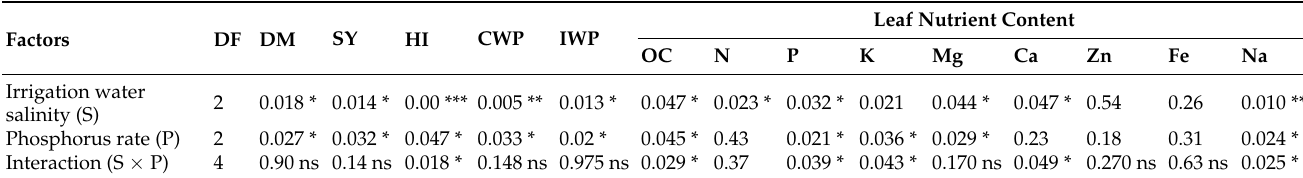
Table 1. Analysis of variance (ANOVA) showing p-value of different leaf nutrient contents as